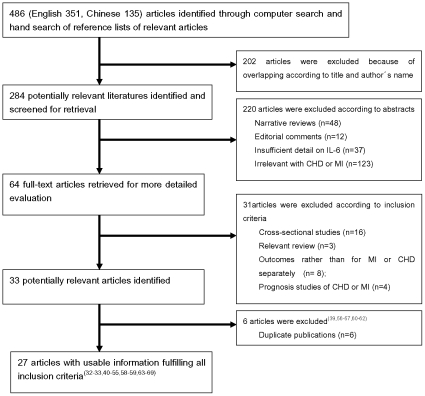
Flow diagram summarizing the search strategy for meta-analysis of IL-6 gene −174 G>C,−572G>C and CHD.